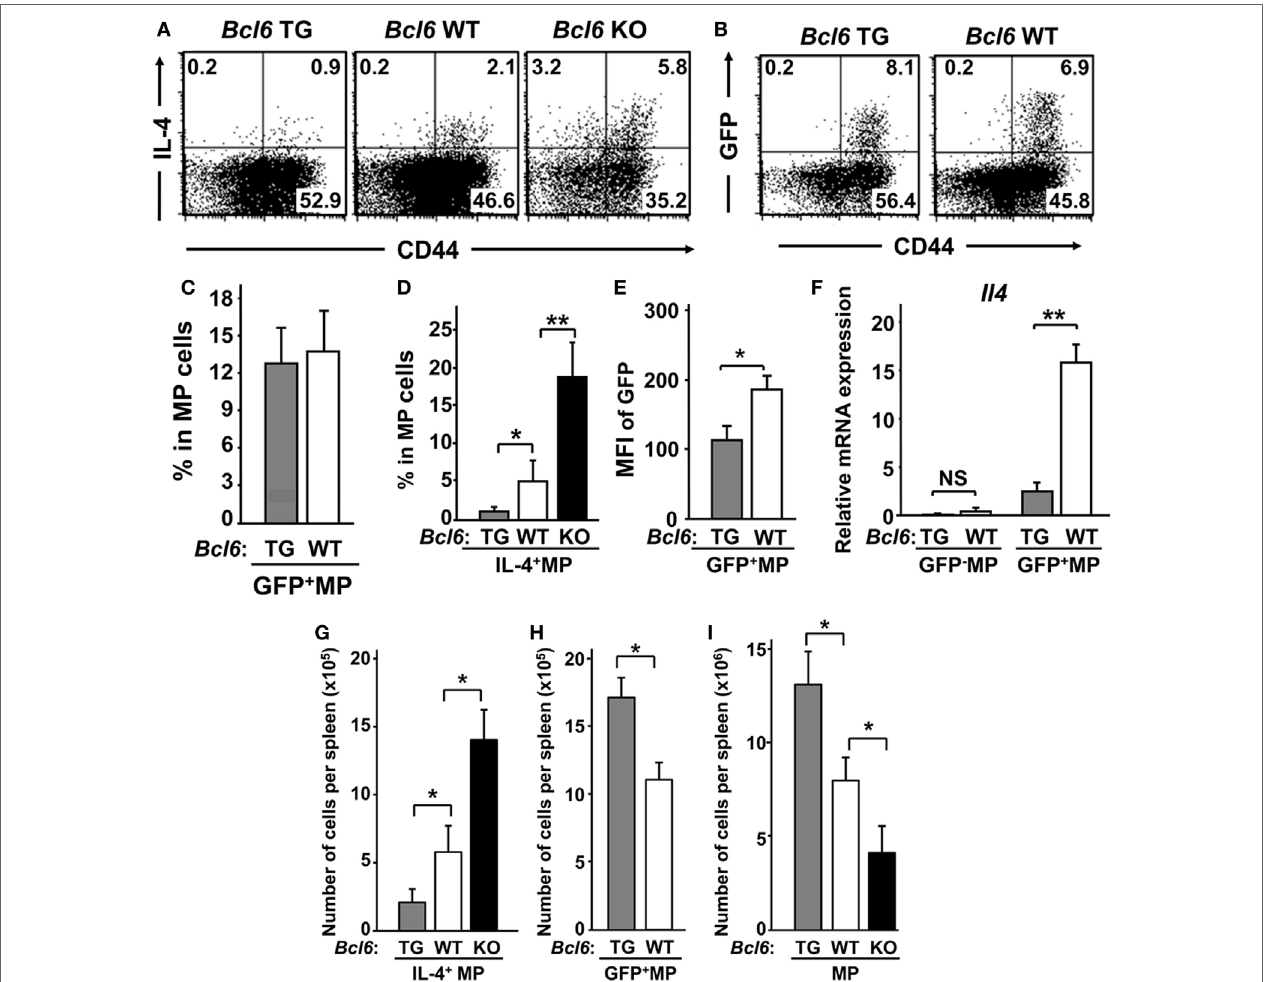
FigUre 1 | IL-4 + MPT cells in mice with varying genetic Bcl6 expression. (a,B) FACS analysis of intracellular IL-4 + [ (a) Bcl6 -TG, Bcl6 -WT, and Bcl6 -KO] and CNS2-activation-related GFP + [ (B) Bcl6 -TG and Bcl6 -WT] MPT cells in a CD44 high population by gating CD4 + CD49b − T splenocytes at rest. The presented data are representative of four independent experiments. The numbers in the corners represent the percentages of gated T cells. (c,D) Frequency of GFP + [ (c) Bcl6 -TG and Bcl6 -WT] and IL-4 + [ (D) Bcl6 -TG, Bcl6 -WT, and Bcl6 -KO] MPT cells. (e) MFI of GFP in MPT cells from Bcl6 -TG and Bcl6 -WT mice. (F) qRT-PCR analysis of the relative expression of Il4 in GFP − and GFP + MPT cells from Bcl6 -TG and Bcl6 -WT spleens. (g–i) Absolute cell numbers of populations of IL-4 + [ (g) Bcl6 -TG, Bcl6 -WT, and Bcl6 -KO], GFP + [ (h) Bcl6 -TG and Bcl6 -WT], and total (i) MPT cells in one spleen. Data are presented as the mean ± SEM ( n = 7–9). * P < 0.05; ** P < 0.01, comparison between two groups as indicated. Bcl6, B-cell lymphoma 6; CNS, conserved noncoding sequence; FACS, fluorescence-activated cell sorting; GFP, green fluorescent protein; KO, knockout; MFI, mean fluorescence intensity; MPT cell, memory phenotype CD4 + T cell; NS, not significant; TG, transgenic; WT,